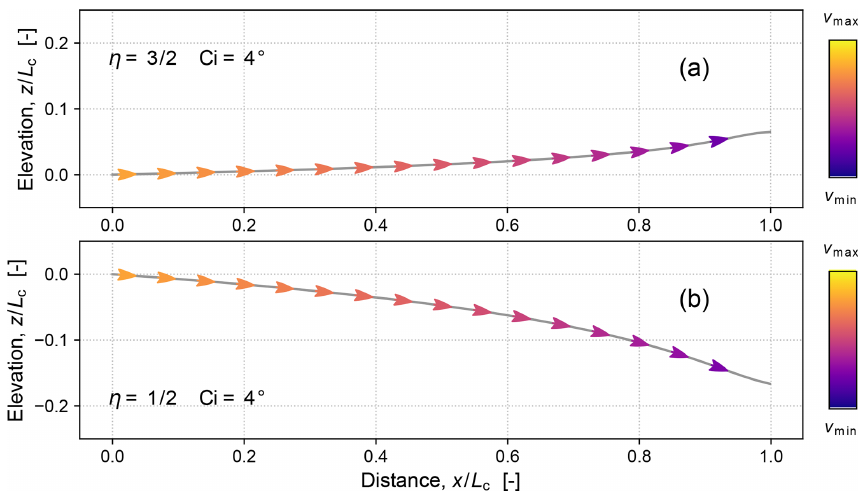
and (b) η = 1 , with µ/η = 1 and Ci = 4 ◦ obtained by numerically integrating Hamilton’s 2 2 2